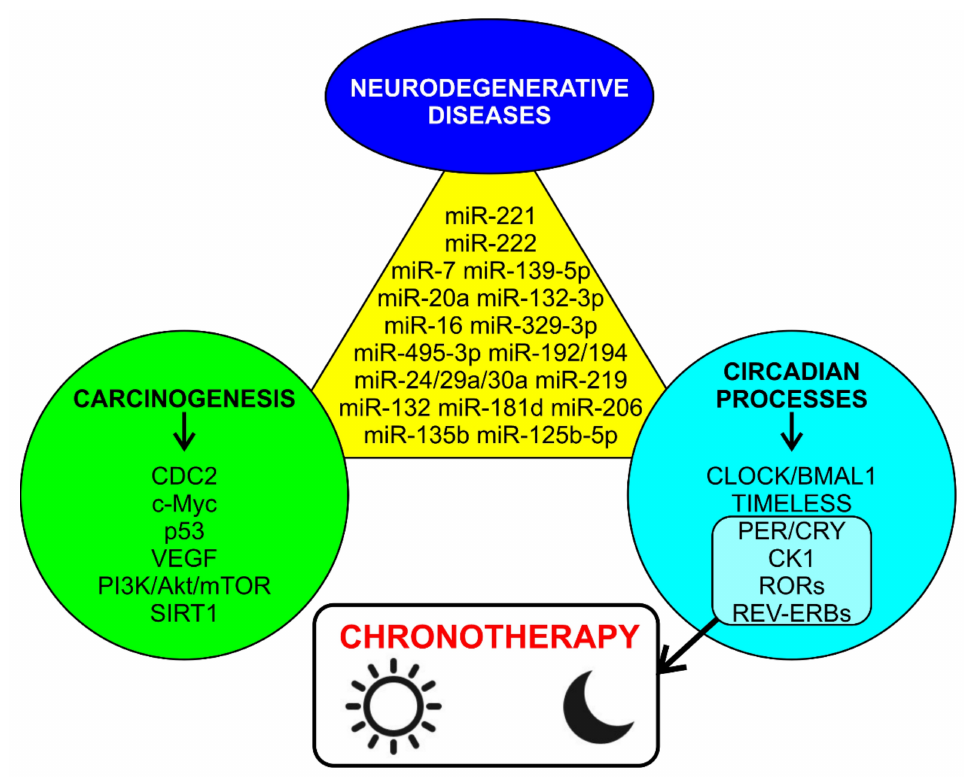
Figure 5. miRNAs involved in inverse comorbidity mechanisms for the modulation of neurodegener- ation, carcinogenesis and circadian